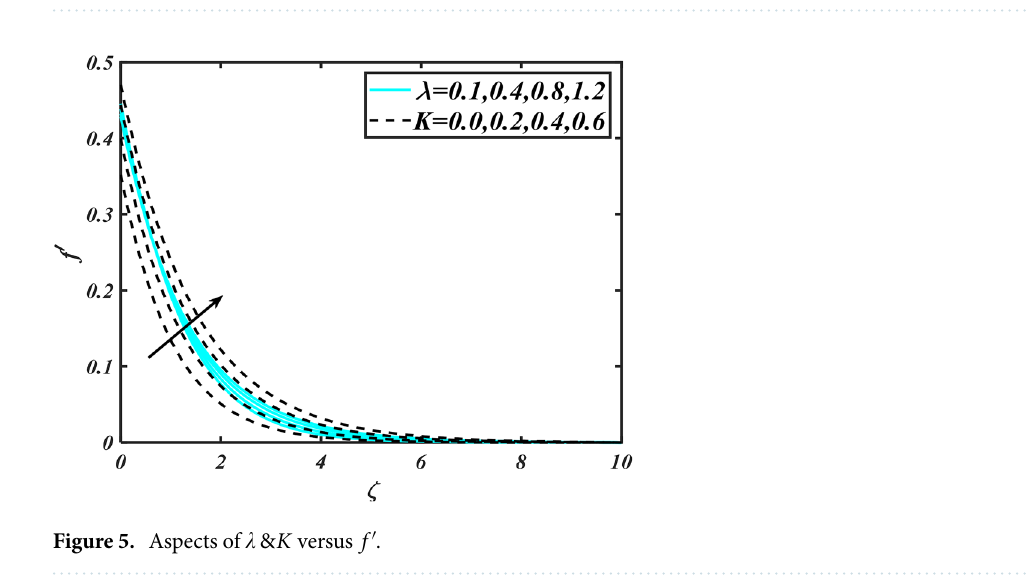
Figure 4. Aspects of B 2 & Nr versus f ′ .